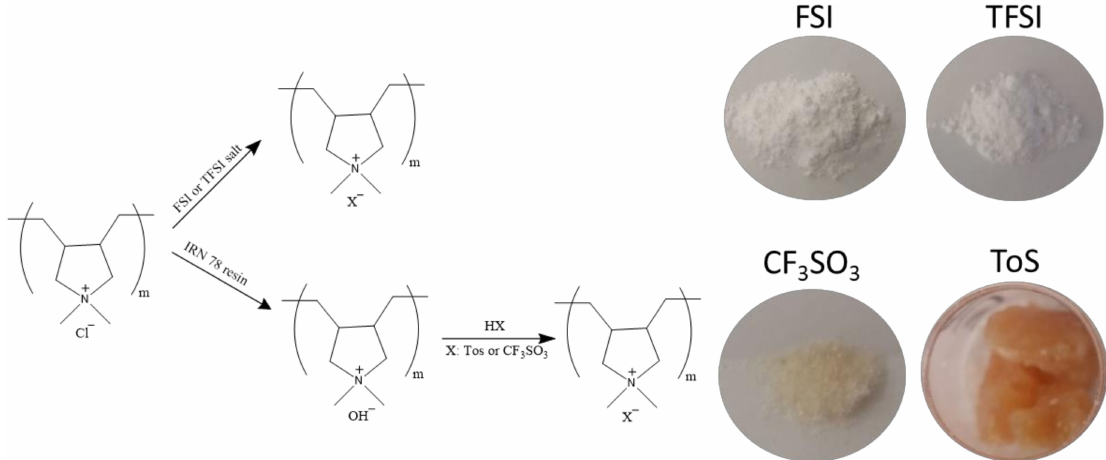
Figure 2. Synthesis of di ff erent polyelectrolyte poly(diallyldimethylammonium) (PolyDADMA X)